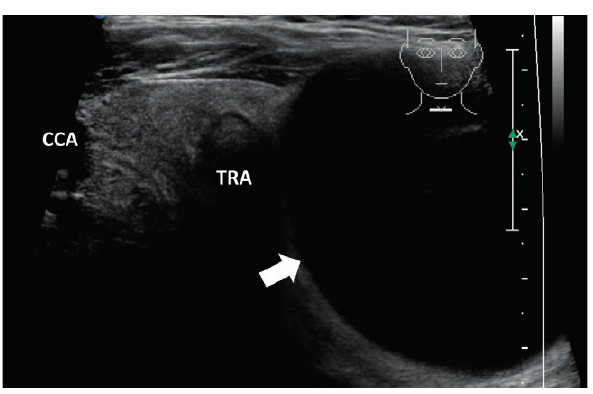
Fig. 1b. Twelve months post 3× PEIT. small solid nodule (empty arrow), size 14 × 11 × 8 mm and volume 0.7 mL as residue of cyst: inhomogeneous structure, mostly isoechoic, focally hypoechoic areas, no recurrence of the liquid component; transverse.